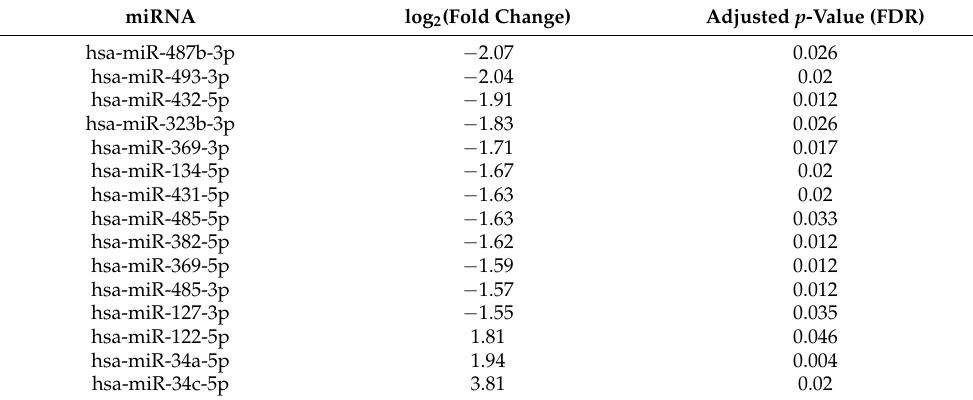
Table 2. First trimester differentially expressed miRNAs in plasma of high risk of preterm birth group compared to the control. miRNA log 2 (Fold Change) Adjusted p -Value